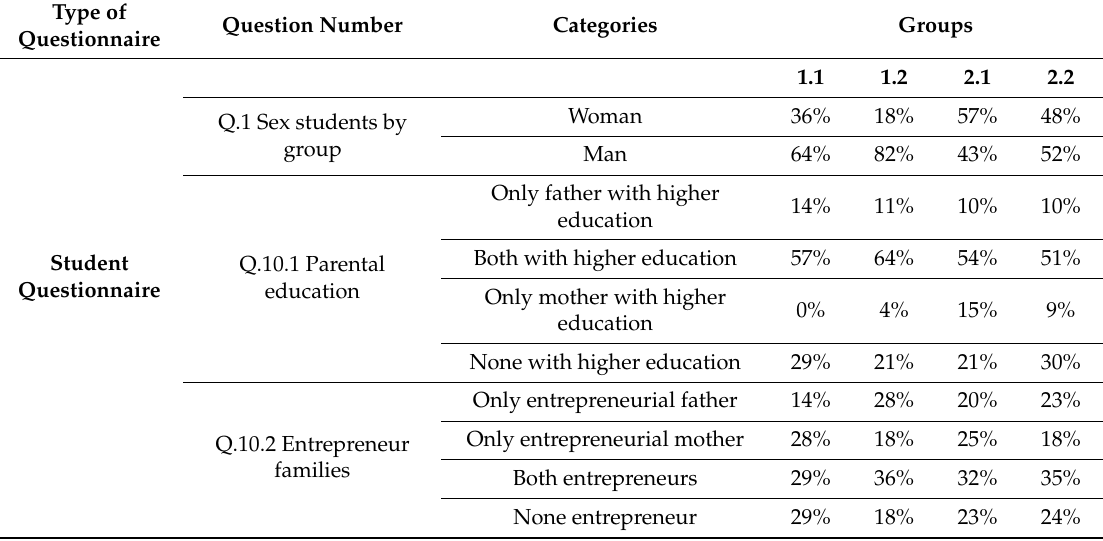
Table 3. Percentage breakdown by PCA group.